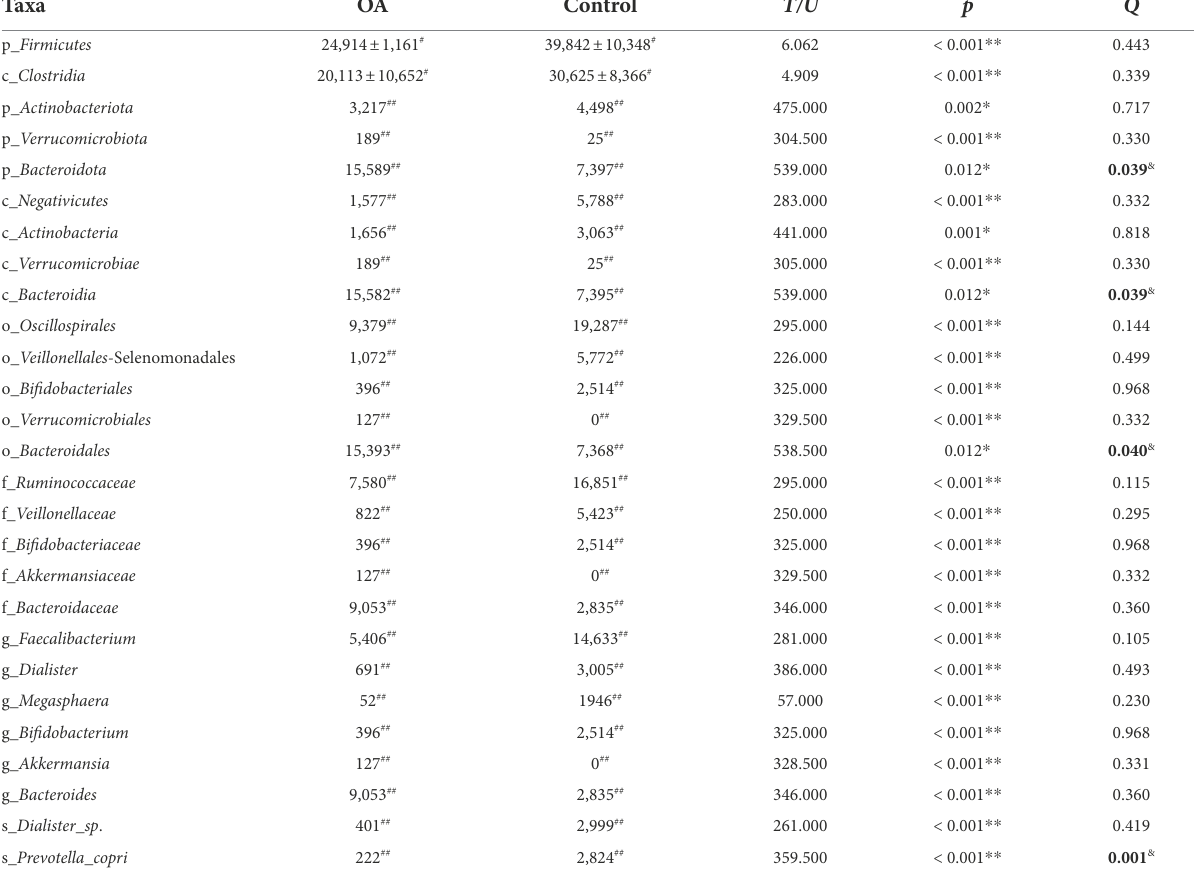
TABLE 4 Absolute abundance of species with significant difference between groups.